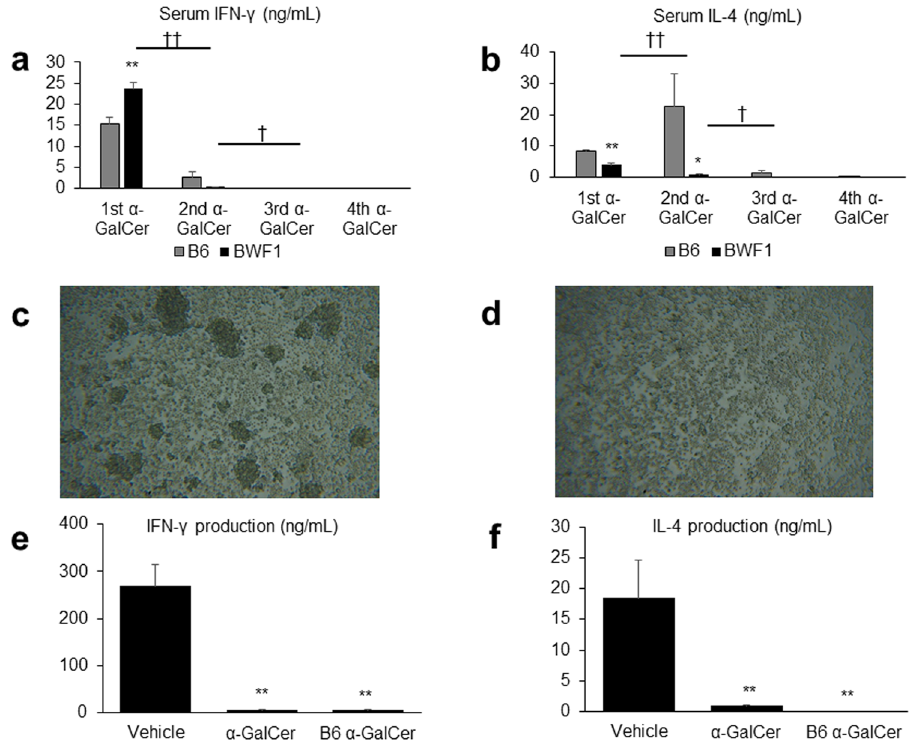
Figure 6. Repeated alpha-galactosylceramide ( α -GalCer) injection induces anergy in NKT cells to α -GalCer. ( a ) Serum IFN- γ levels 12 hours after α -GalCer injection and ( b ) IL-4 levels 3 hours after α -GalCer injection in (NZB/NZW) F1 (BWF1) and C57BL/6 J (B6) mice. The mice were injected with 2 μ g/body of α -GalCer once a week for 4 weeks, and cytokine levels were evaluated after every injection ( n = 4 in each group). * p < 0.05, ** p < 0.01 compared with B6 mice. †† p < 0.01 compared with the levels after the first α -GalCer injection. † p < 0.05 compared with the levels after the second α -GalCer injection. Microphotographs of liver mononuclear cells (MNCs), stimulated by α -GalCer in the ( c ) vehicle and ( d ) α -GalCer groups (original magnification, 100 × ). In vitro production of ( e ) IFN- γ and ( f ) IL-4 from liver MNCs in BWF1 mice treated with α -GalCer or vehicle, and B6 mice treated with α -GalCer. Liver MNCs were obtained 8 weeks after the last α -GalCer or vehicle injection and were stimulated with α -GalCer for 48 hours ( n = 4 in each group). ** p < 0.01 compared with the vehicle group of BWF1